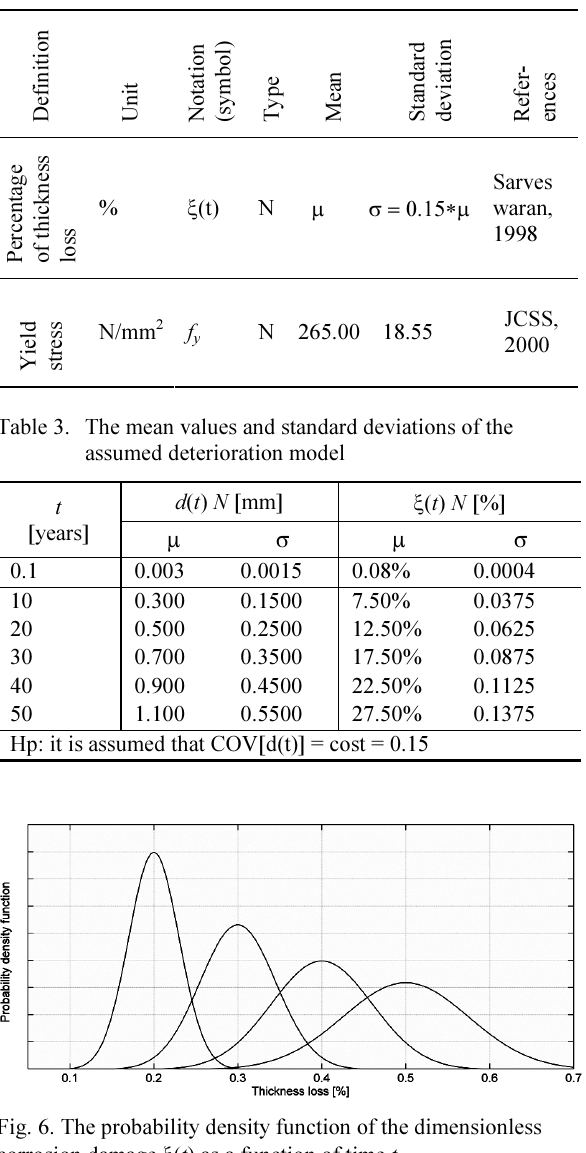
2 and a mean thickness loss